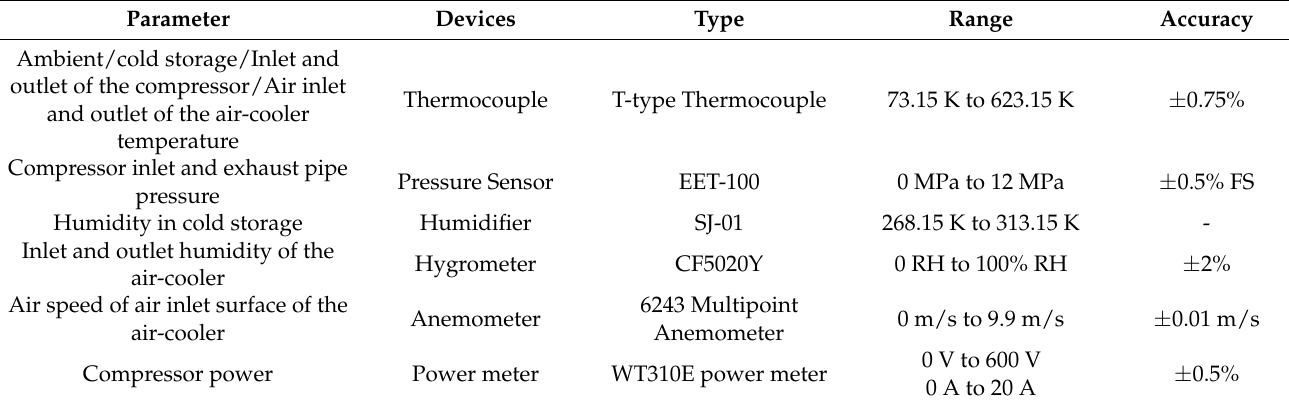
Figure 1. Schematic diagram of the experimental setup. Table 1. Specifications of the control and measuring devices.